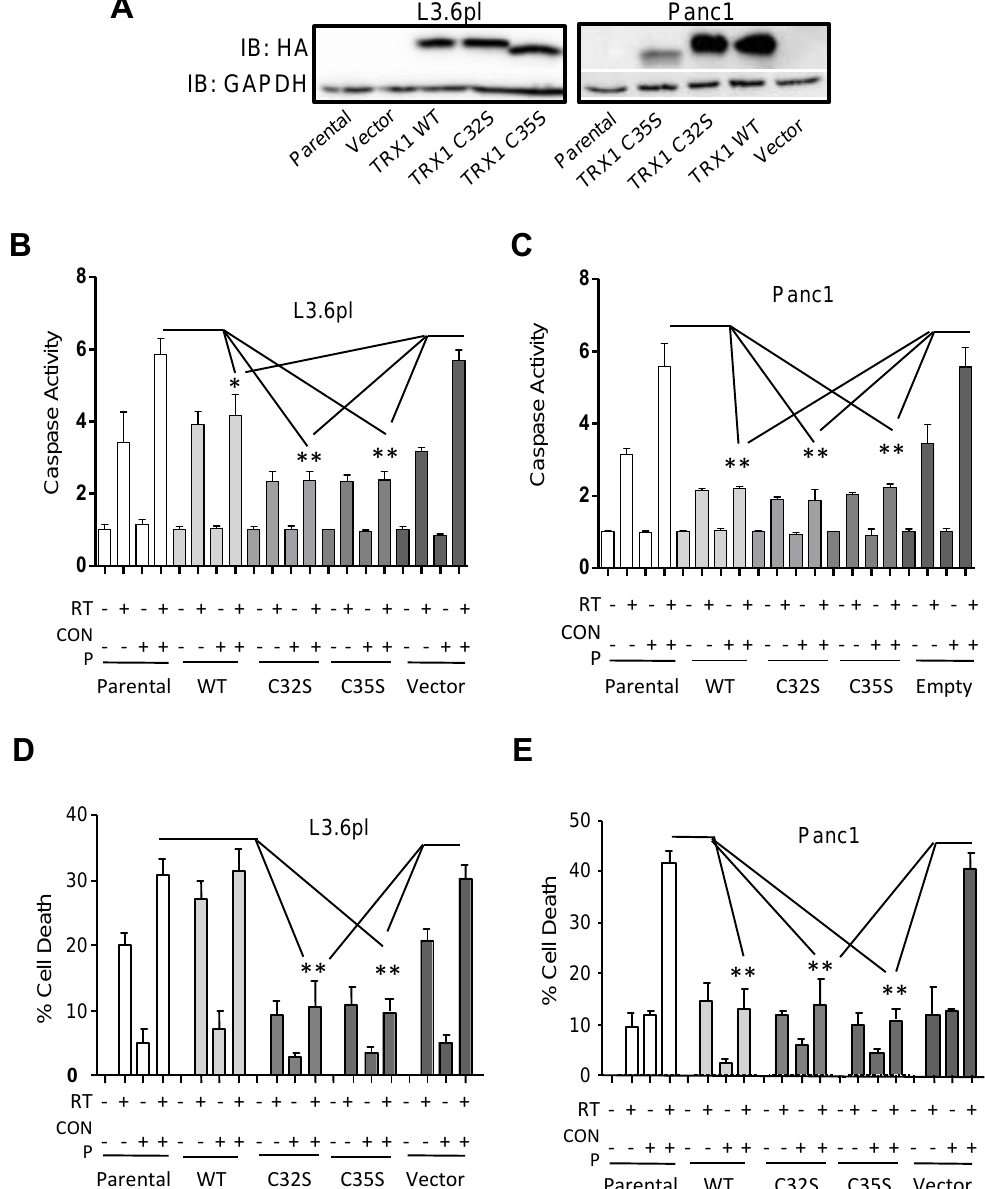
Figure 7. CONPs are Unable to Drive RT-Induced Apoptosis in the Absence of TRX1 Oxidation. The L3.6pl and Panc1 cells with stable expression of TRX1 (verified by western blot ( A )) were treated with or without 10 µM CONPs for 24 hours prior to 0 Gy or 5 Gy RT. Caspase 3/7 activation ( B , C ) and cell viability ( D , E ) were determined 72 and 96 hours post RT, respectively. Results were presented as relative to untreated control group. The control viability value was set as 100% viability. The % cell death was calculated by subtracting % viability from 100%. * p < 0.001.